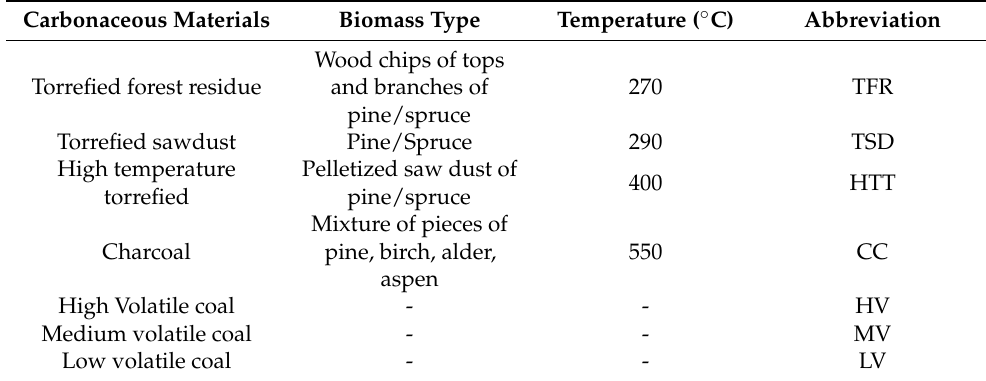
Table 1. Selected carbonaceous materials with abbreviations and their approximate pre-treatment temperatures.